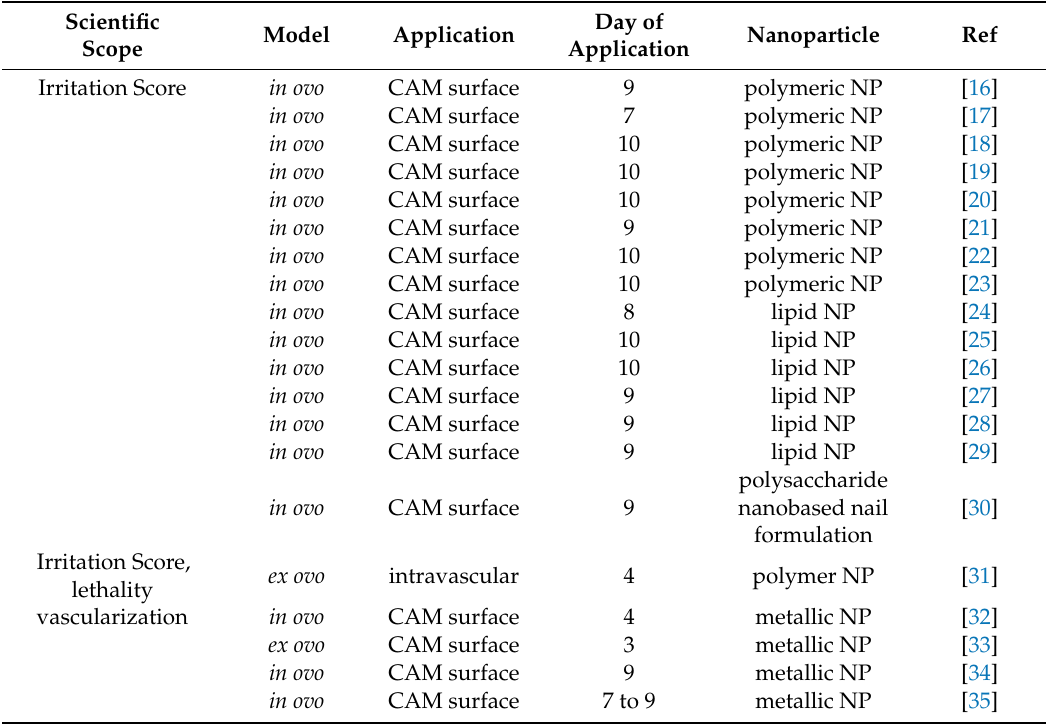
Table 1. This table summarizes the results of a systematic database research in Medline (https: // pubmed.ncbi.nlm.nih.gov) using the following search commands: “((CAM assay) OR (CAM model) OR (chorioallantoic membrane assay) OR (chorioallantoic membrane model) OR ( in ovo ) OR ( ex ovo )) AND ((nanoparticle) OR (nanoparticulate) OR (nanoparticular)) AND ((toxicity) OR (toxic e ff